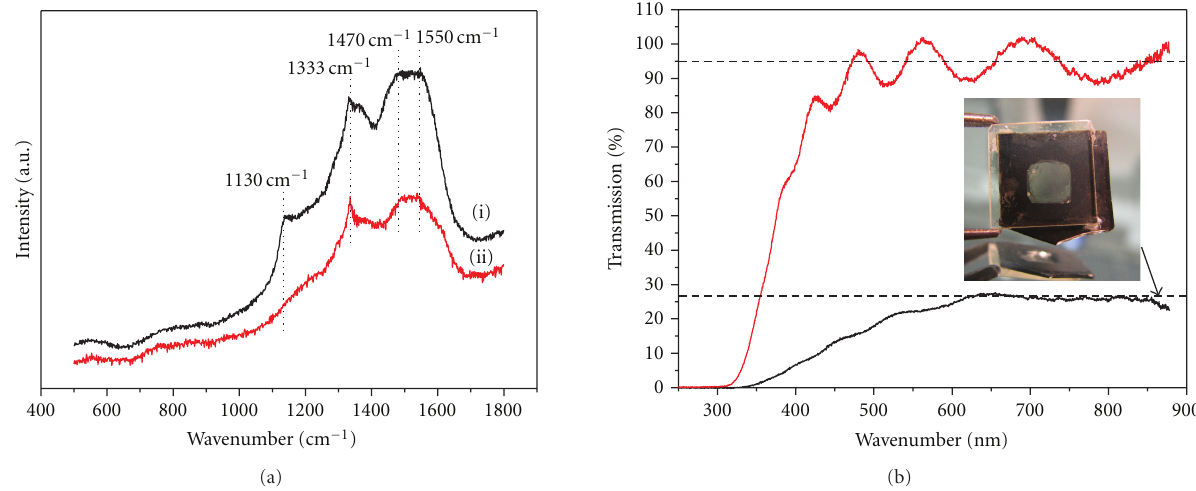
Figure 4: (a) The Raman spectra of (i) front side and (ii) rear side of diamond membrane. (b) The UV-Vis transmission spectra of ITO and fabricated OTE device consisting of a diamond membrane on an ITO